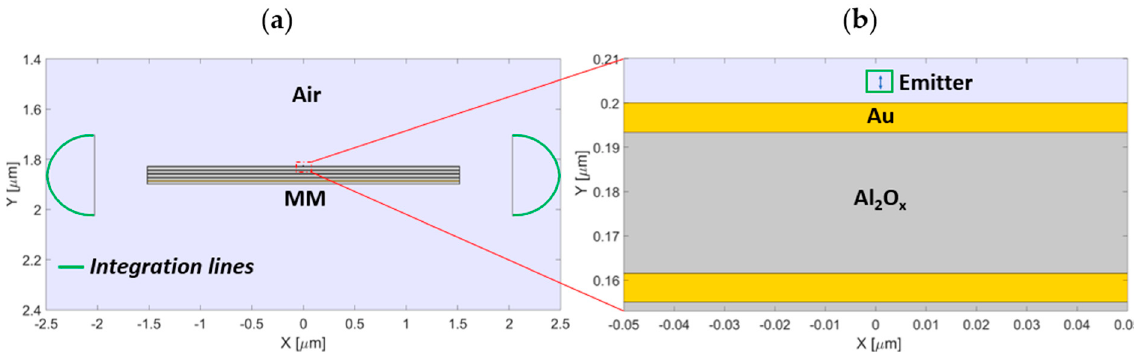
Figure 1. ( a ) Geometrical scheme exploited for the performance analysis. ( b ) Magnification of the red − dotted region highlighted in ( a ), showing the dipole and the square along which we calculated the total power.